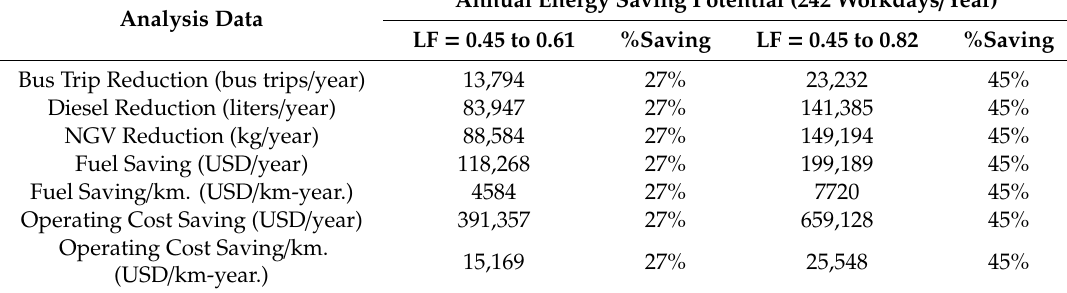
Table 7. Annual Energy Saving Potential after Applied PBRU on Rama 2 Road during the p.m. Peak